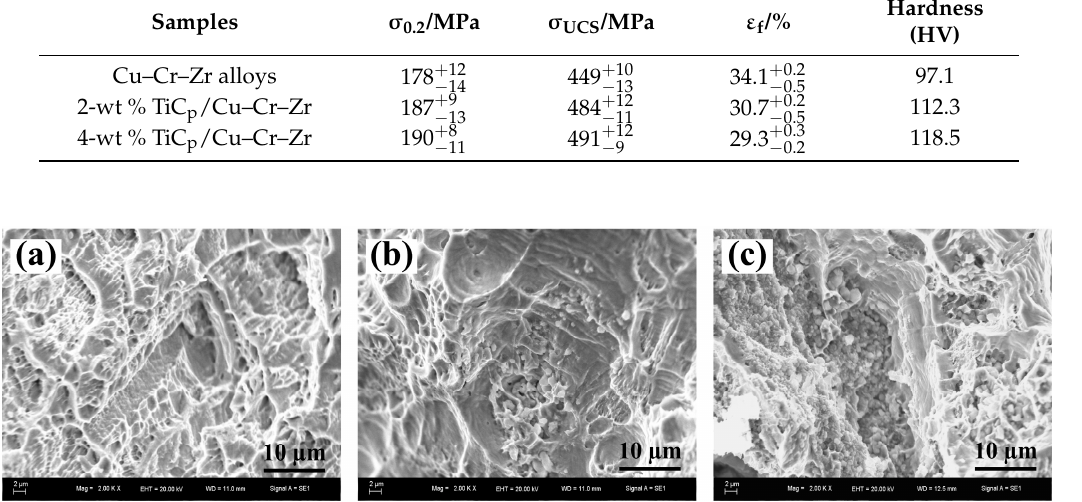
Figure 5. The fracture surface of ( a ) Cu–Cr–Zr alloys, ( b ) 2-wt % nano-sized TiC p /Cu–Cr–Zr